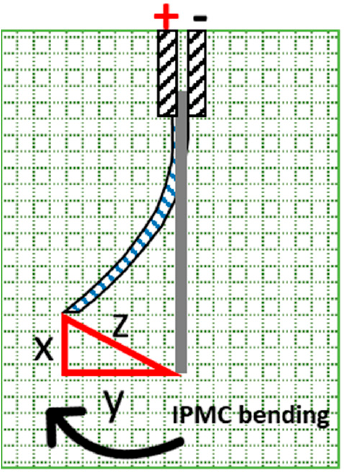
Figure 1. Digital camera setup to measure IPMC displacement. Displacement values of the IPMC are calculated using basic trigonometry in this setup. Referring to the triangle with sides xyz in Figure 2, the tip-to-tip displacement can be calculated using Pythagoras’s theorem. Similarly, trigonometric laws such as the Cosine Law can be used to find the bending angle.